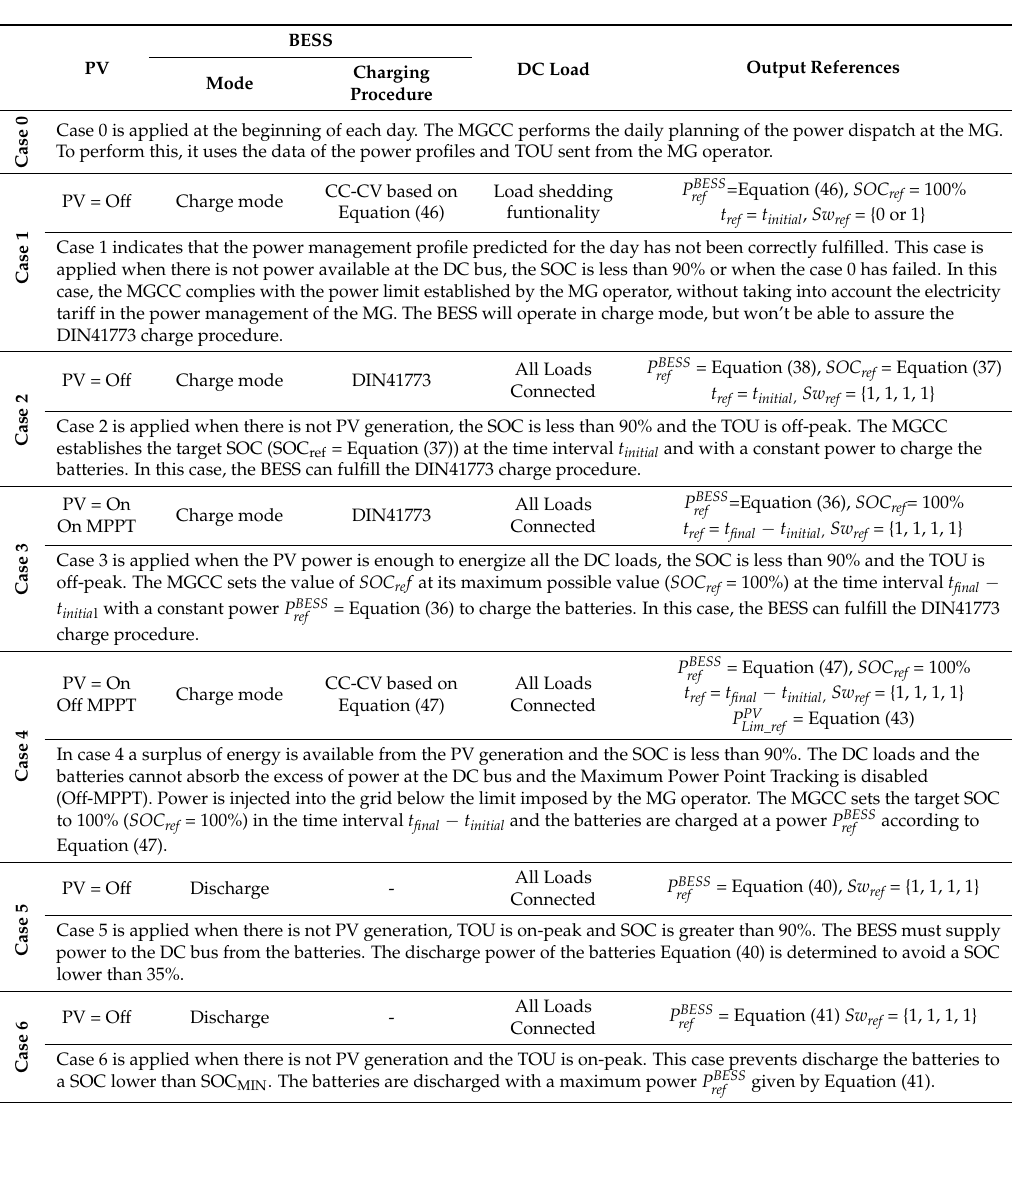
Table 6. Summary of the cases applied set by the